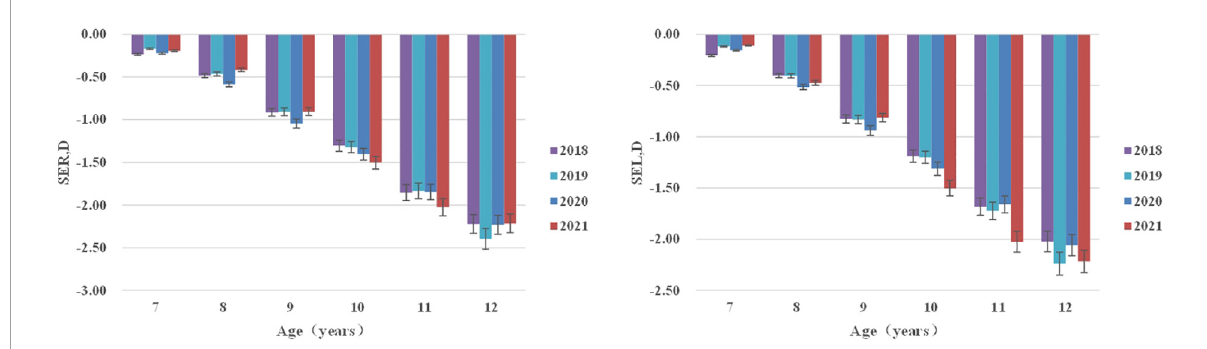
FIGURE1 Spherical equivalent (SE, D) distribution of right/left eyes stratified by age from 2018 to 2021.